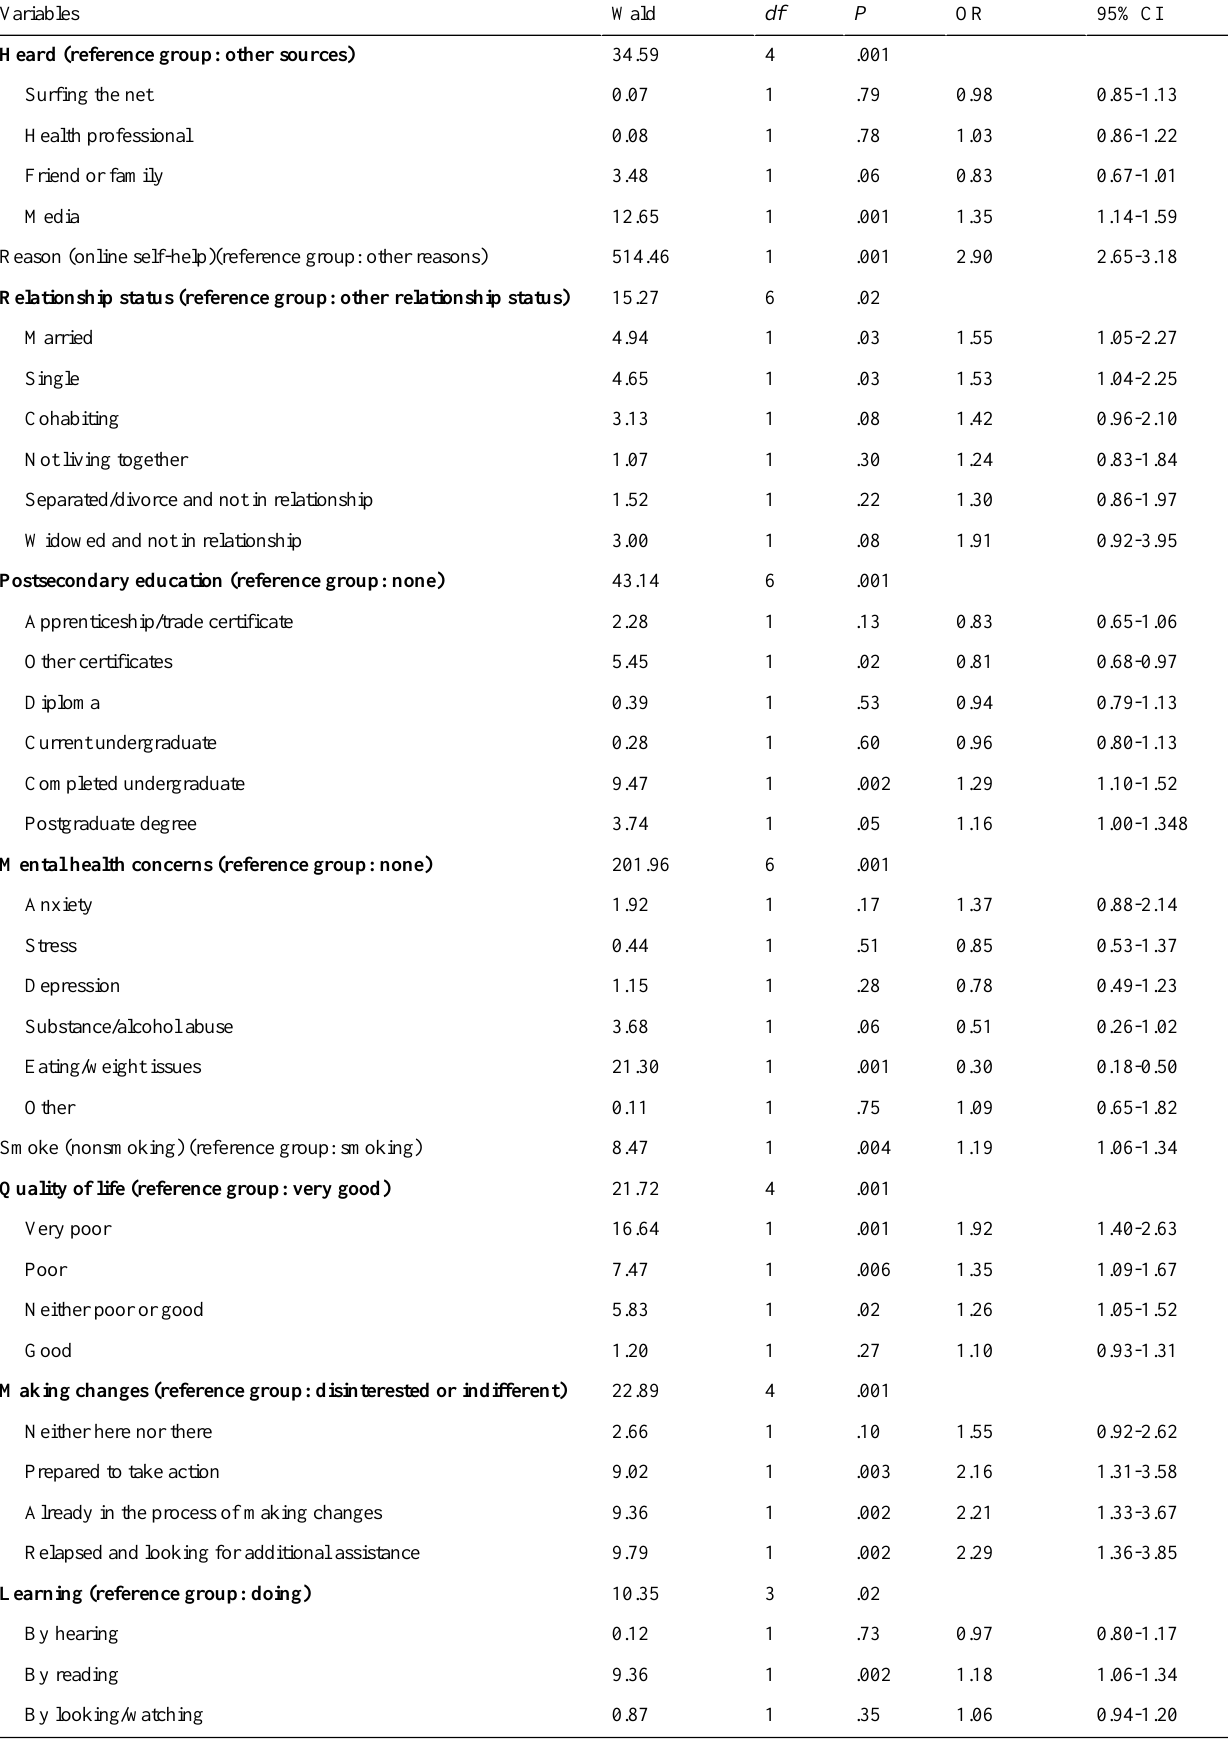
Table 2. Binary logistic regression model for pretreatment